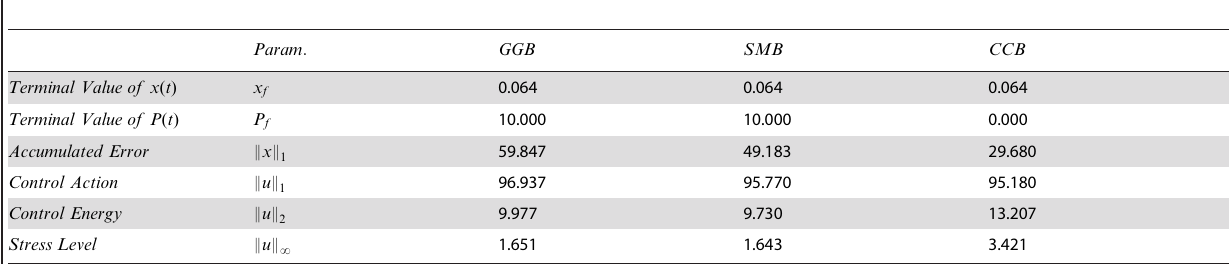
Table 3. Simulation Results of Three Goal Pursuit